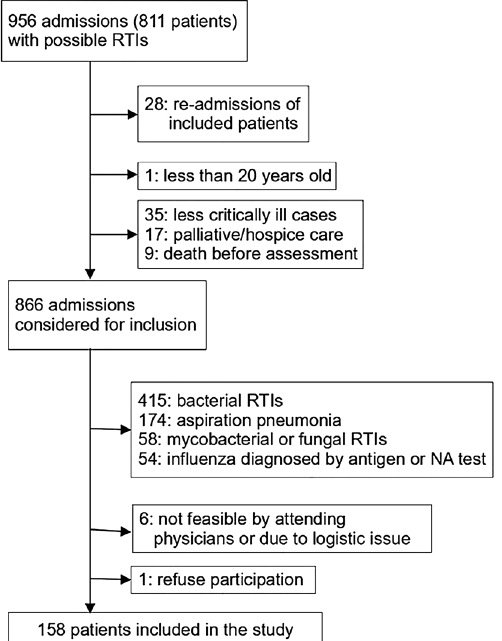
Figure 1. Inclusion and exclusion of the study patients. RTIs respiratory tract infections, NA nucleic